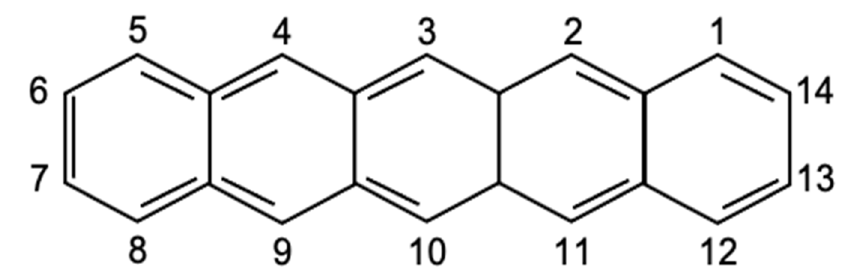
Figure 1. Carbon numbering of pentacene.